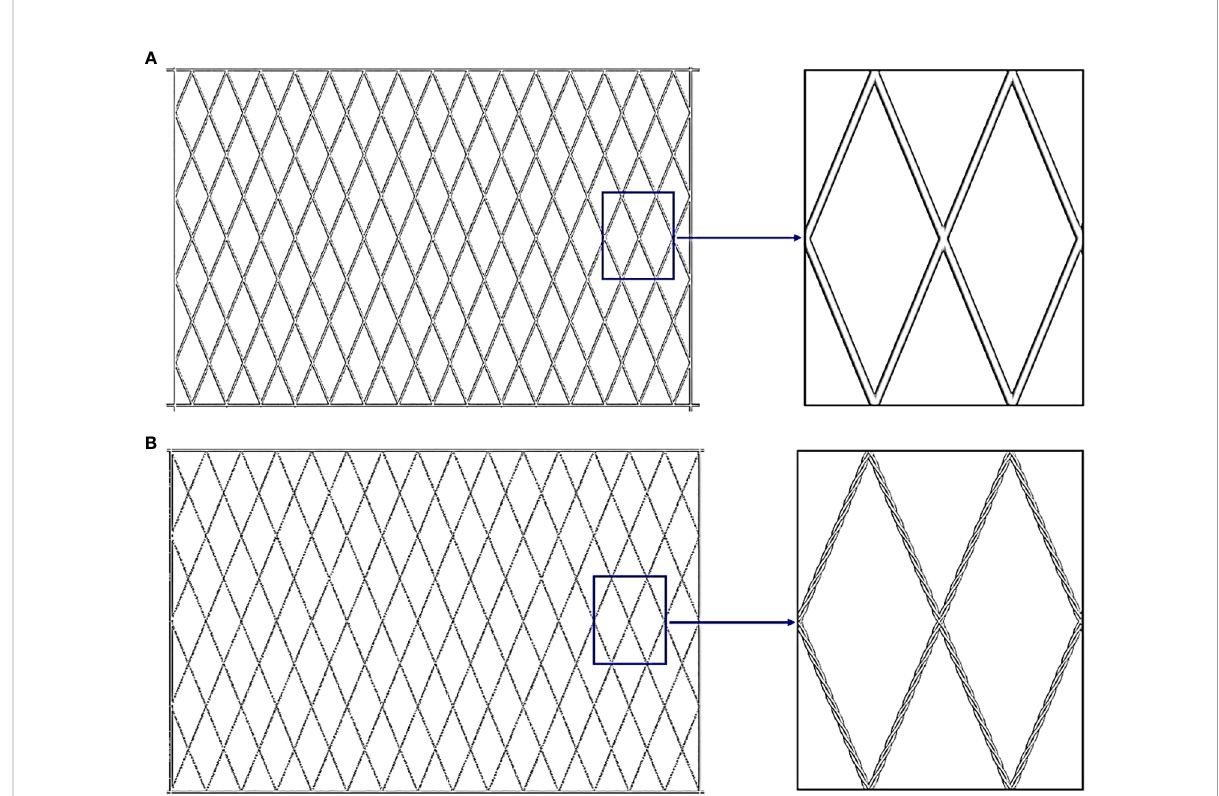
FIGURE 1 The representatives of the net panels, (A) the equivalent-twine net and (B) the twisted-twine